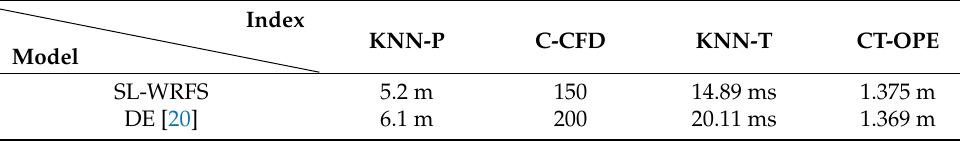
Table 1. Comparison of Database Generation Methods.